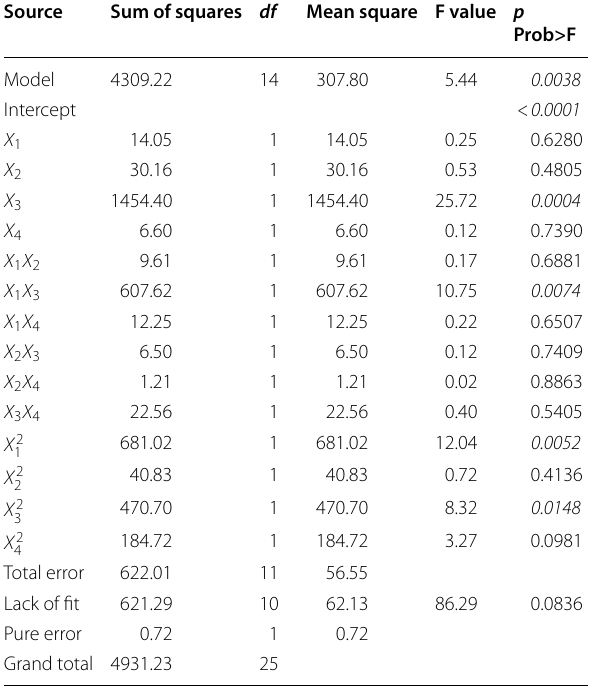
Table 4 ANOVA for response surface quadratic model Source